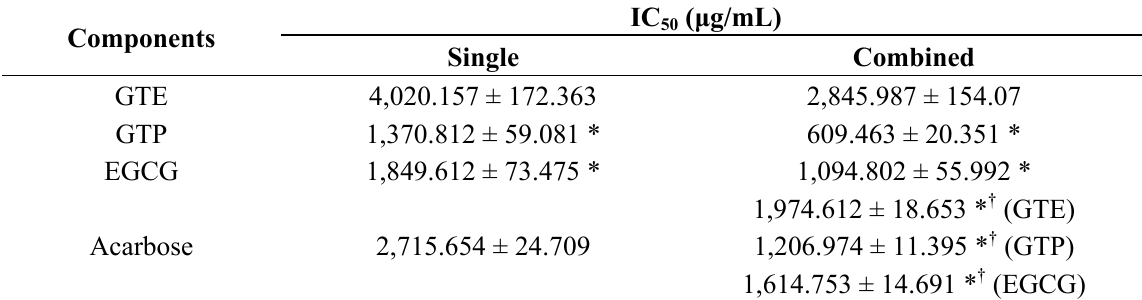
Table 2. The IC50 values of GTE, GTP, EGCG alone and their combination with acarbose on inhibiting α -amylase